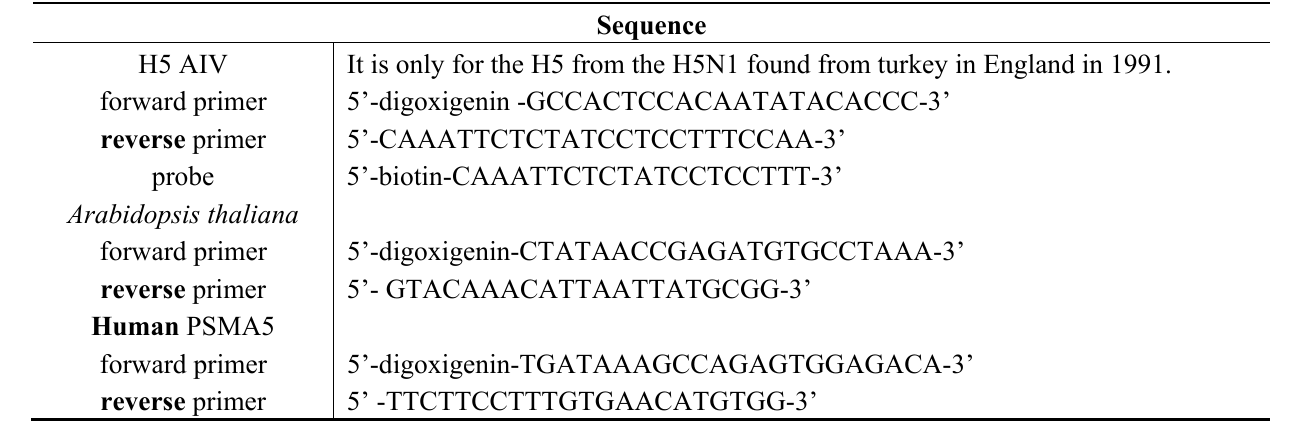
Table 2. Probe and PCR primers used in this study and their